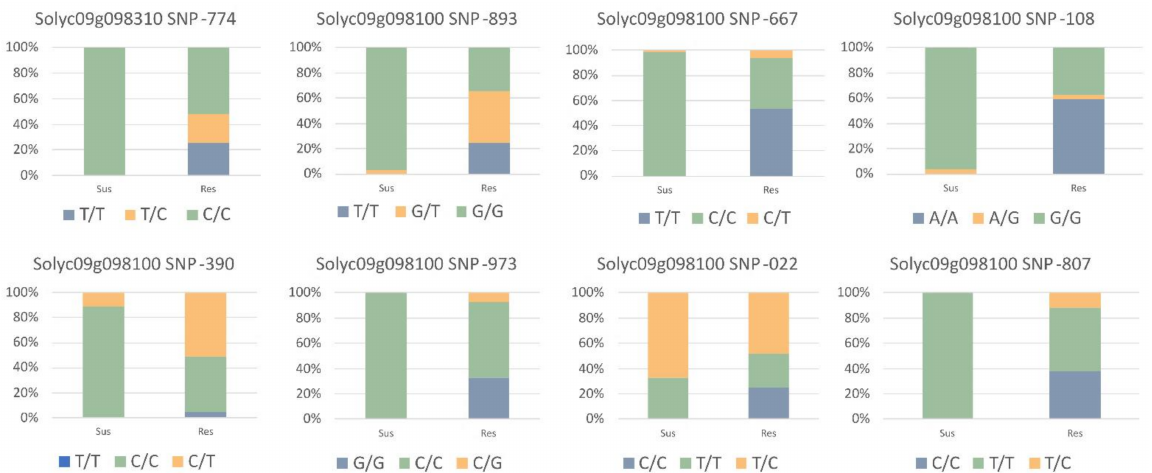
Figure 2. Genotype frequencies of validated SNP targets in a total of 121 individuals including 14 resistant and 17 susceptible breeding lines. The percentage of homozygous reference (blue), homozygous alternate (green), and heterozygous allele (orange) are shown in tested